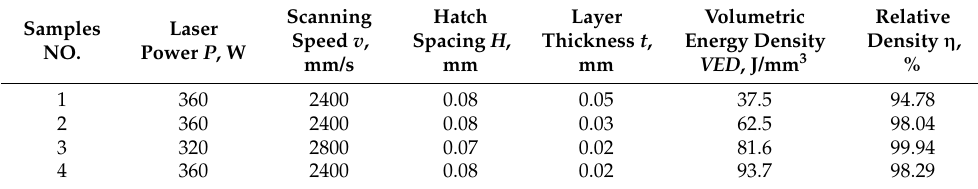
Table 2. Process parameters of LPBF manufacturing